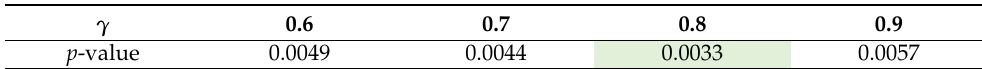
Table 6. The results of the p -value under the ALP .